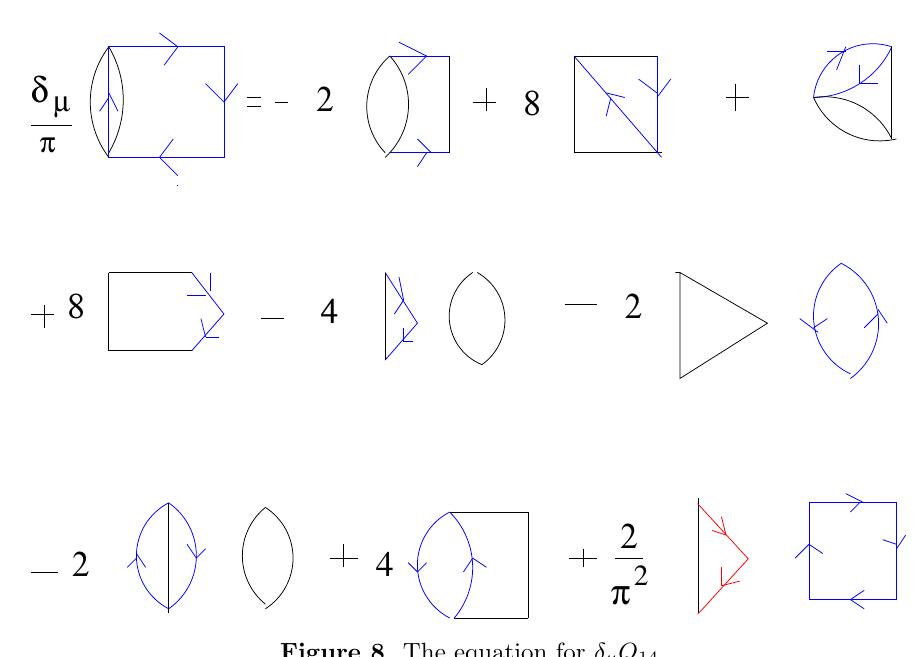
Figure 8 . The equation for (cid:14) (cid:22) Q 14